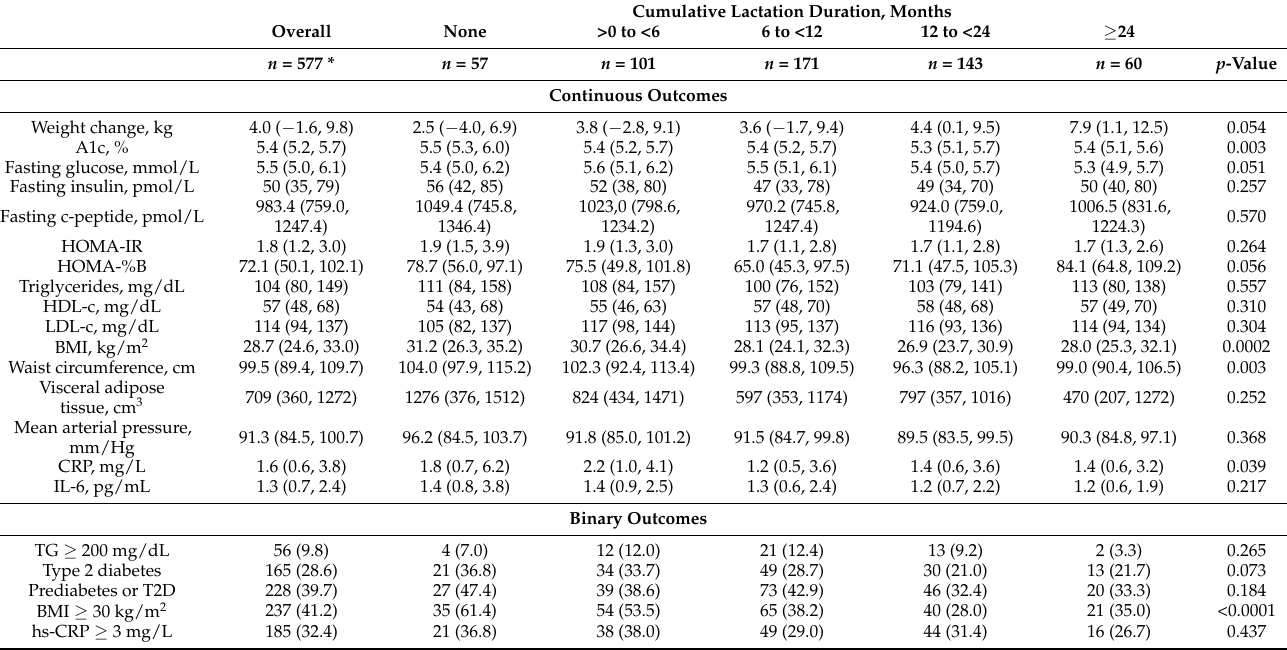
Table 2. Cardiometabolic outcomes 9–16 years after the index pregnancy among women with a history of gestational diabetes, overall and stratified by cumulative lactation